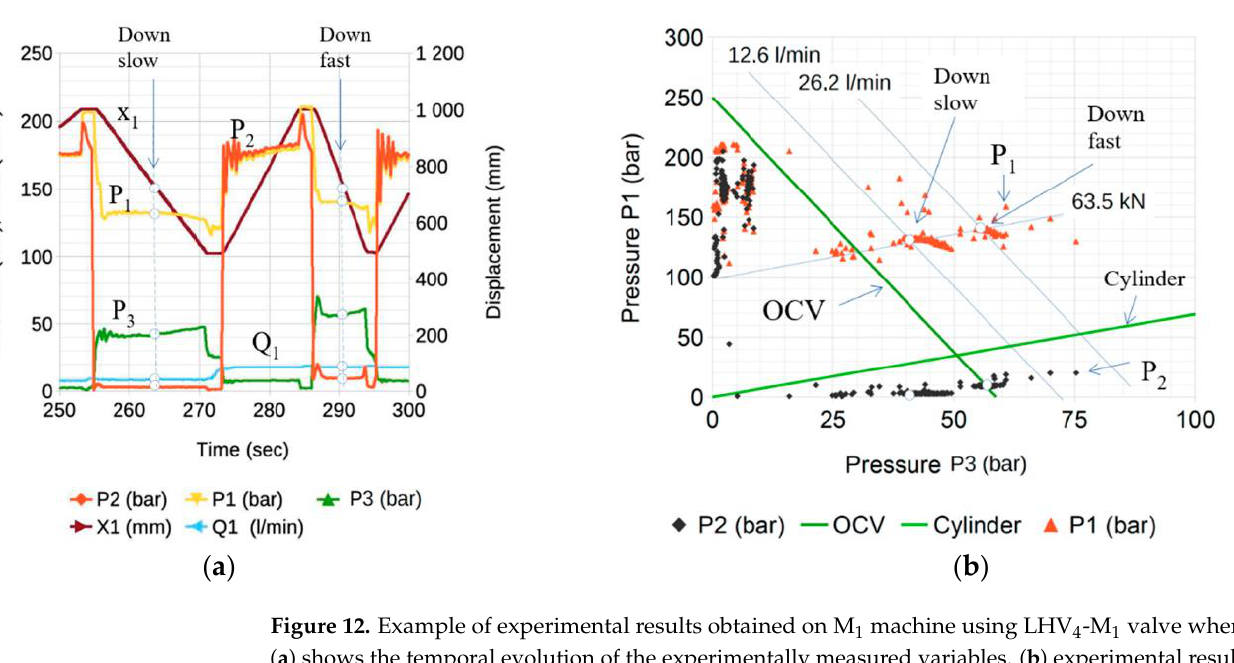
Table 3. List of main characteristics of used sensors.